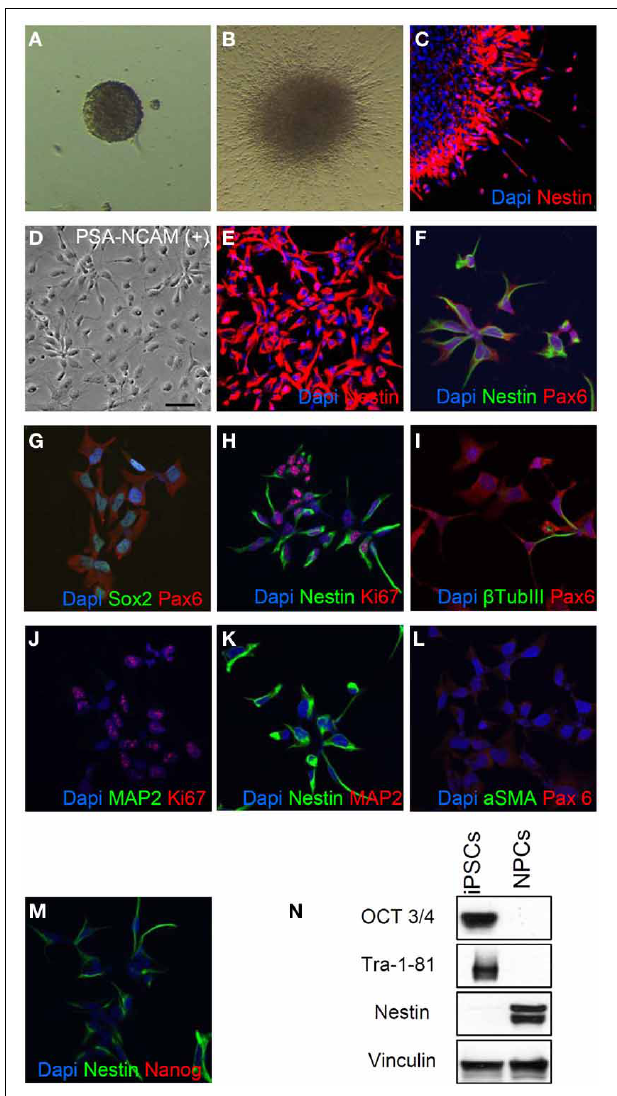
FIGURE 2 | Generation of neural progenitor cells (hNPs). (A,B) Representative images of embryoid bodies (A) and rosettes (B) . (C) Rosettes are positive for the early neural precursor marker Nestin. (D) This representative image shows the typical morphology of PSA-NCAM positive purified hNPs, (E–H) Most of PSA-NCAM positive cells are positive for Nestin, Pax6 and Sox2, typical hNP makers; they are also positive for Ki67 confirming that they are self-renewing. (I) about 5% of cells are positive for β Tubulin III. (J–L) hNPs do not express MAP2 and α SMA, markers of mature neurons and mesodermal cells respectively. (M,N) hNPs do not express the pluripotency markers Nanog, OCT3/4 and Tra-1-81. Scale bar, 50 μ